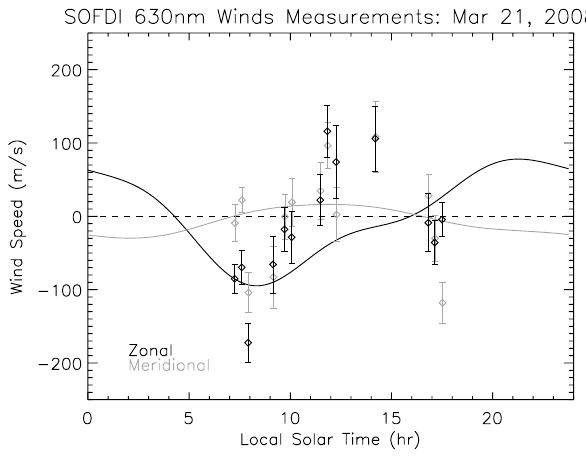
Fig. 3. Daytime OI 630-nm thermospheric winds, represented by diamond points with 1-sigma uncertainty bars, as measured from one field-of-view by SOFDI in Steuben Valley, NY from 28 March 2008. The thin lines are from the HWM07 empirical model. Black data points/lines represent the zonal wind (positive values are east- ward) while gray data points/lines represent the meridional wind (positive values are